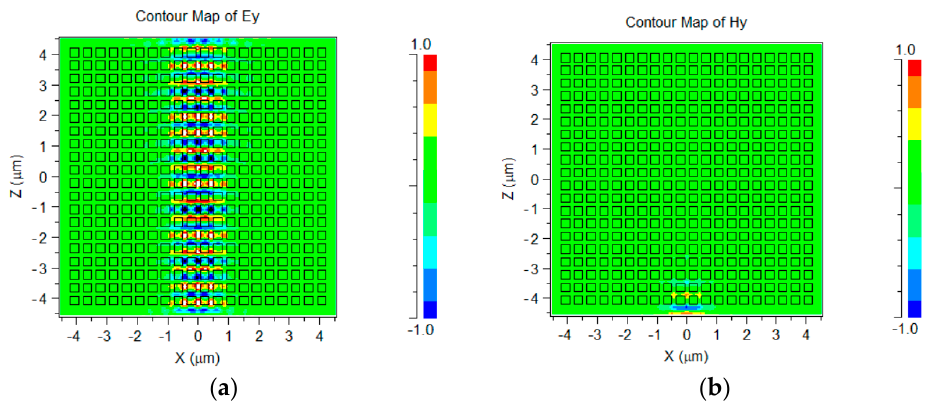
Figure 6. ( a ) Steady-state field distribution in TE mode; ( b ) Steady-state field distribution in TM mode.